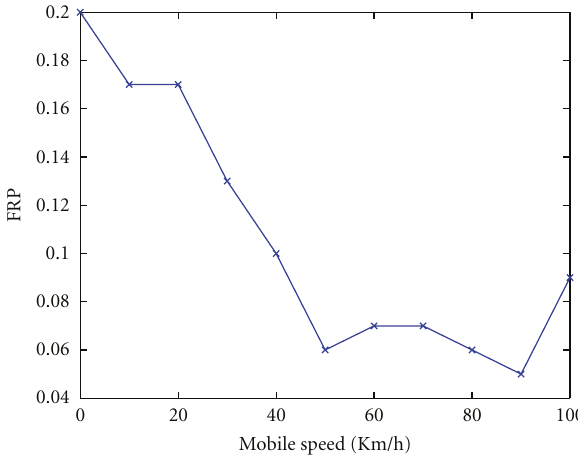
Figure 12: False recognition probability versus mobile speed in typical case for rural area for full class recognition and SNR =